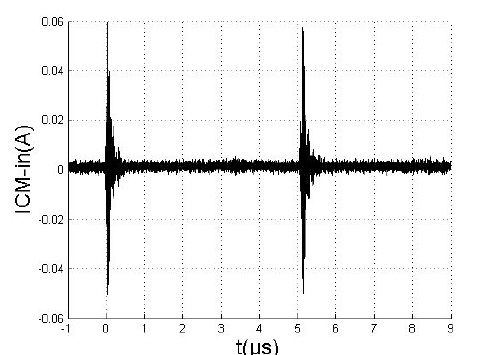
Figure 26: Experimental waveform of the current i